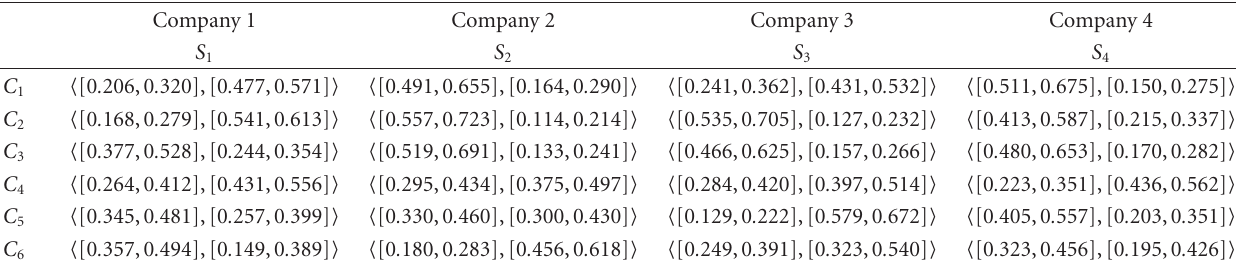
Table 13: Weighted decision